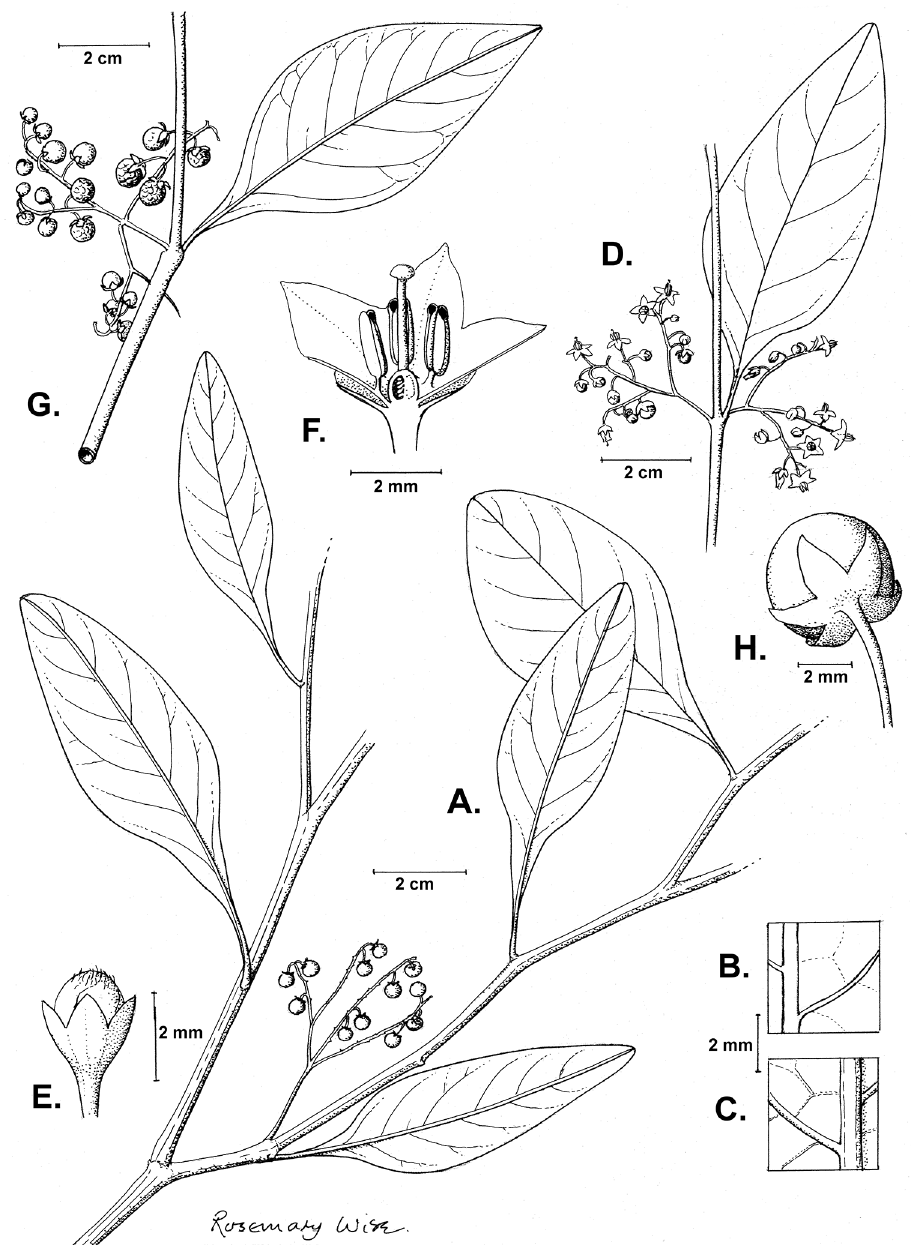
Figure 9. Solanum corymbosum Jacq. A Habit B detail of adaxial leaf surface C detail of abaxial leaf surface D flowering branch E floral bud F dissected flower G fruiting branch H maturing fruit ( A–F van der Werff 14657 G–H Ochoa 14625 ). Drawing by R.